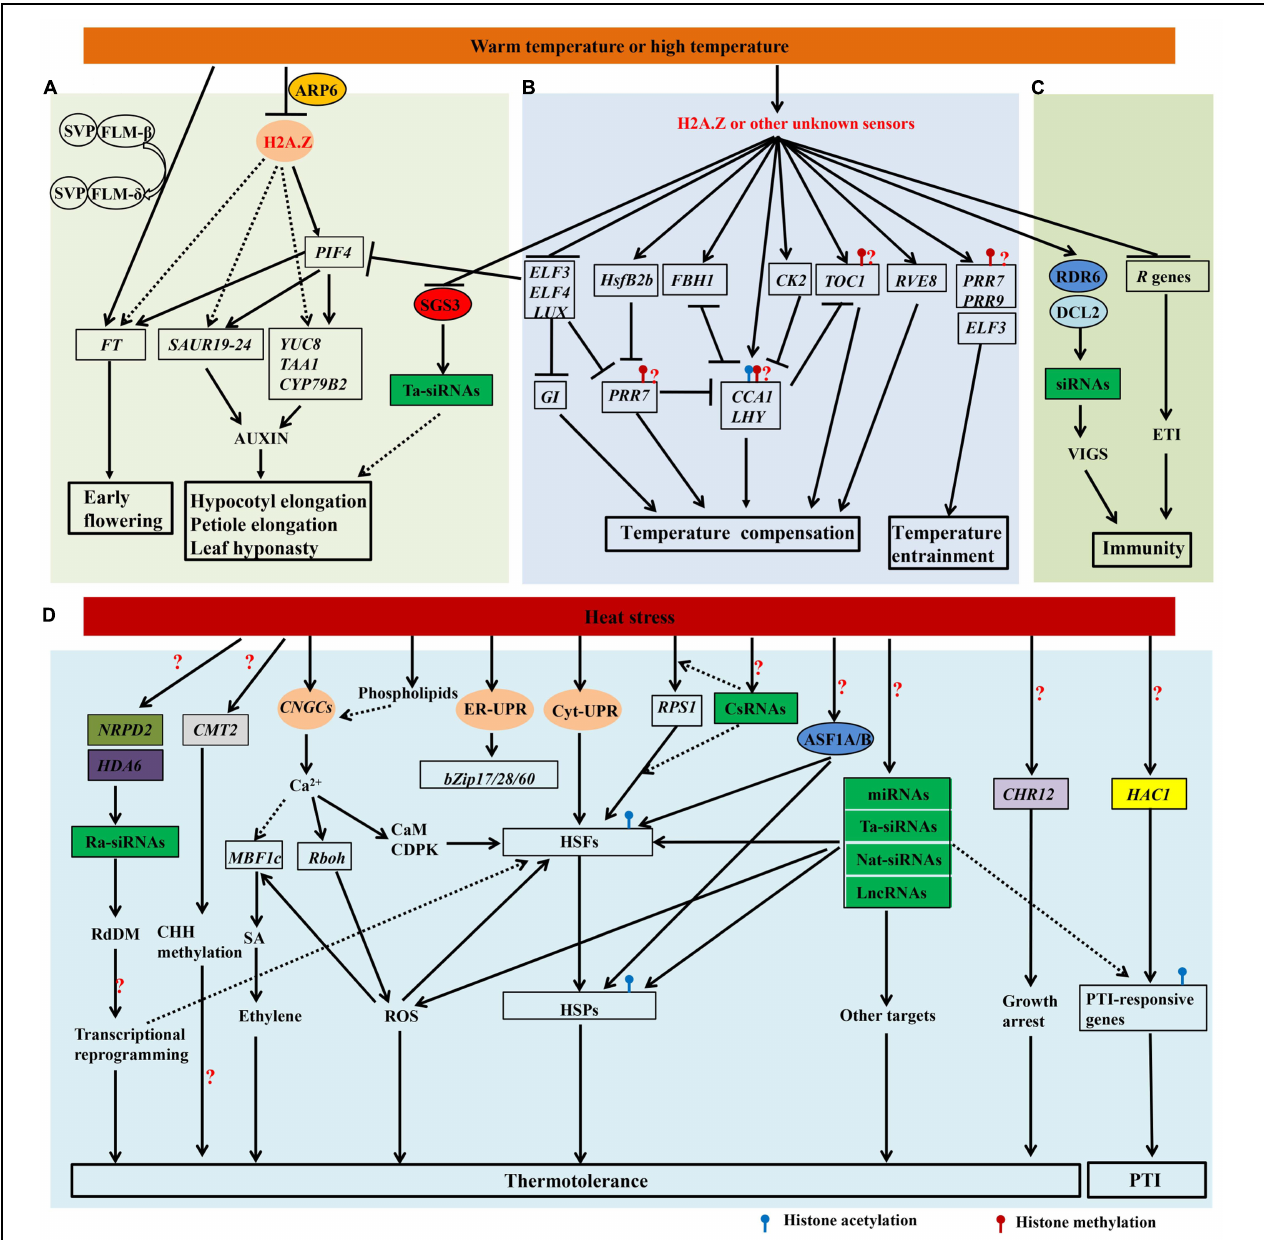
FIGURE 1 | Proposed model integrating genetic and epigenetic controls of heat responses. Genes and proteins are represented in boxes and circles, respectively. The genes and proteins in color are involved in the epigenetic regulation of heat responses. The four putative heat sensors, H2A.Z, the calcium channel in the plasma membrane ( CNGCs ), two unfolded protein sensors in ER (ER-UPR) and the cytosol (Cyt-UPR), are indicated. The speculative regulatory paths are indicated with broken arrows. (A) Warm temperature mediates the morphological acclimation and acceleration of flowering. Under warm temperatures, the expression of PIF4 could be induced by the eviction of H2A.Z at its promoter. PIF4 binds to the promoters of target genes and plays a central role in the morphological acclimation and acceleration of flowering. Warm temperature also induces the transition from SVP-FLM- β to the competing SVP-FLM- δ complex, the latter is then released from the promoter of FT . The inhibition of ta-siRNAs (green box) through the down-regulation of SGS3 protein (red circle) by warm temperature may be also